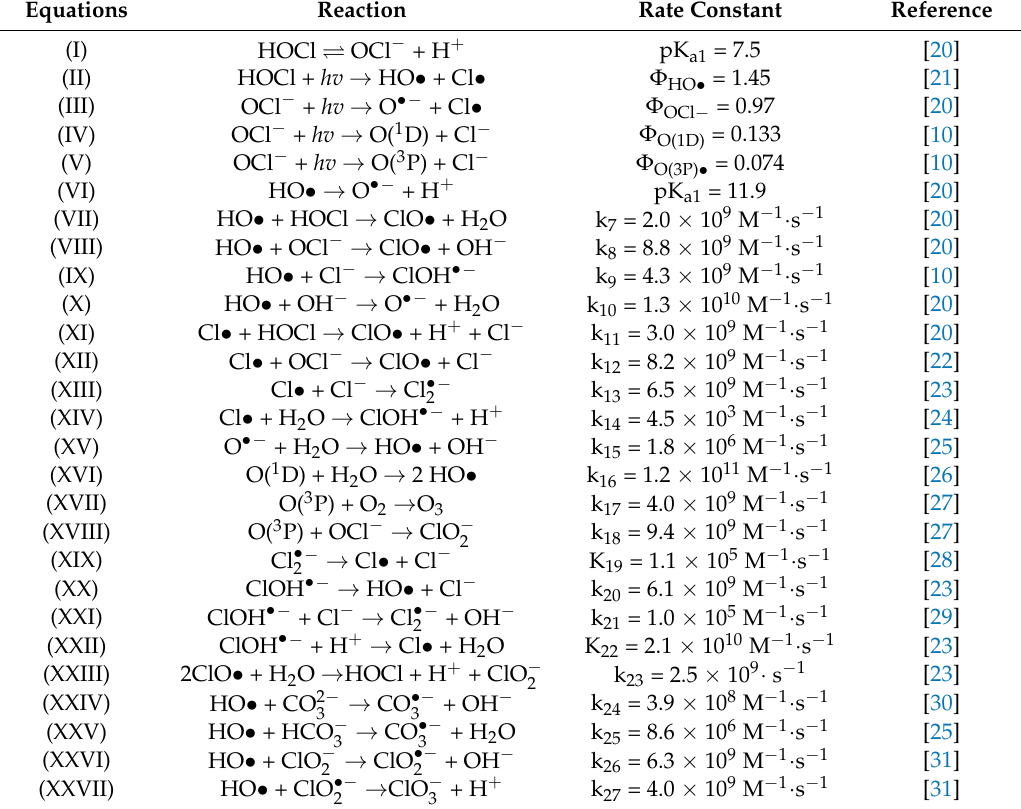
Table 1. Principal reactions in the ultraviolet irradiation of free chlorine (UV/FC) system.